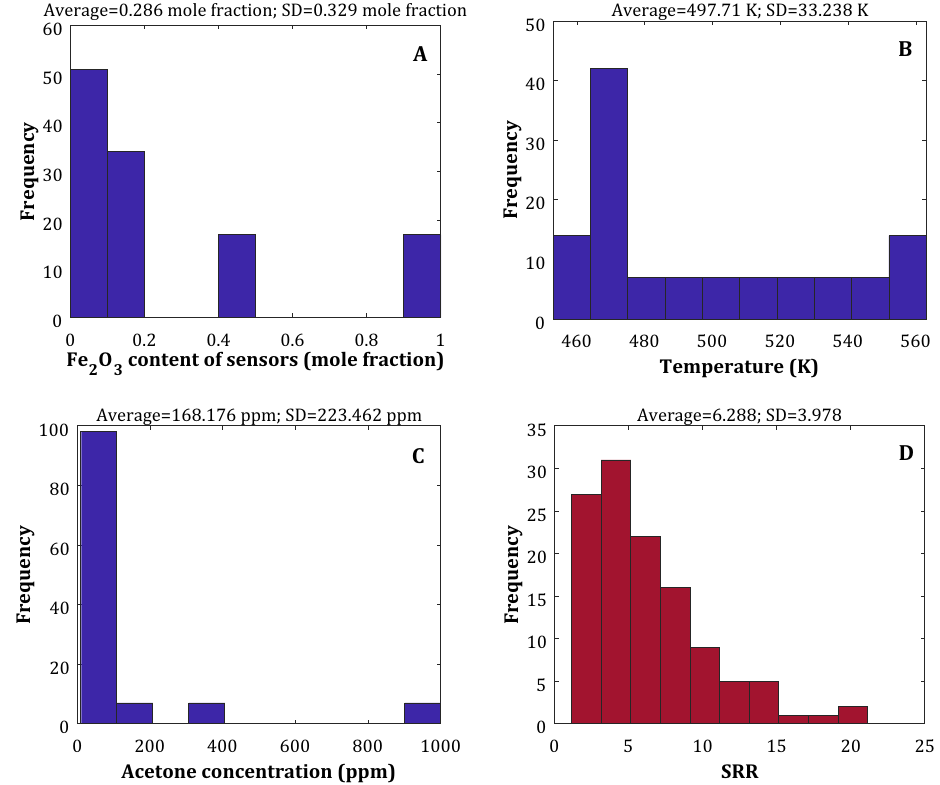
Figure 1. Histograms of the Fe 2 O 3 content of nanocomposite sensors ( A ), operating temperature ( B ), acetone concentration ( C ), and SRR ( D